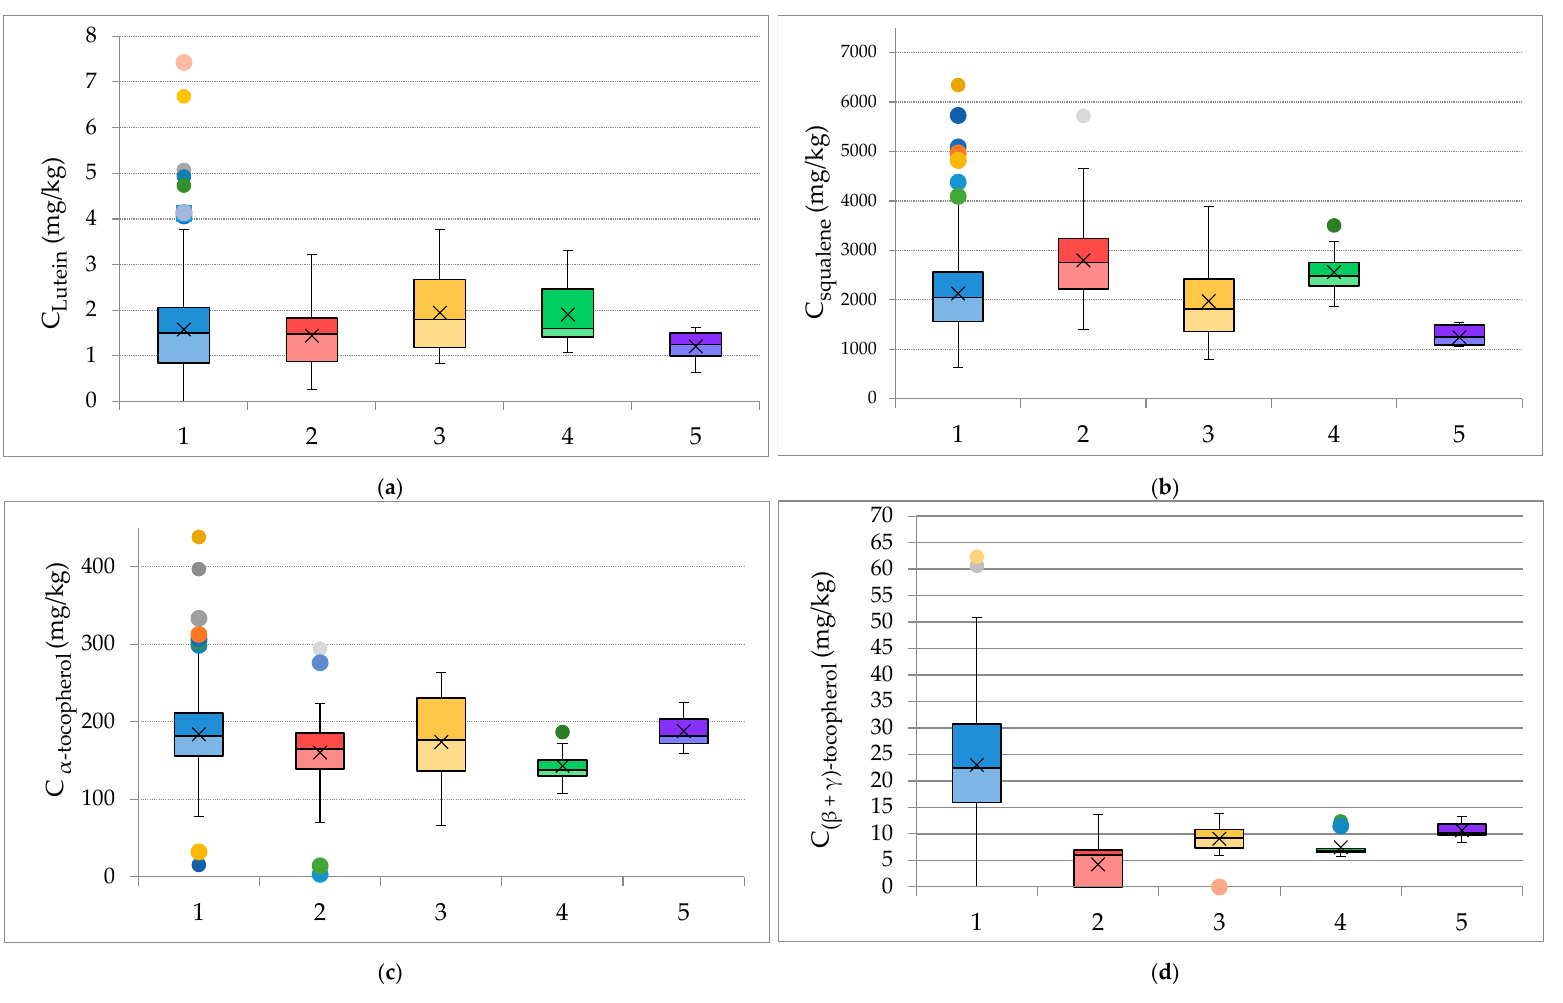
Figure 2. Box and whisker plots, presenting the concentrations of ( a ) lutein, ( b ) squalene, ( c ) α -tocopherol, and ( d ) ( β + γ )-tocopherol according to the geographical origin. 1—Lesvos ( n = 363), 2—Samos ( n = 51), 3—Chios ( n = 20), 4—Ikaria ( n = 12), 5—Fournoi ( n = 6).